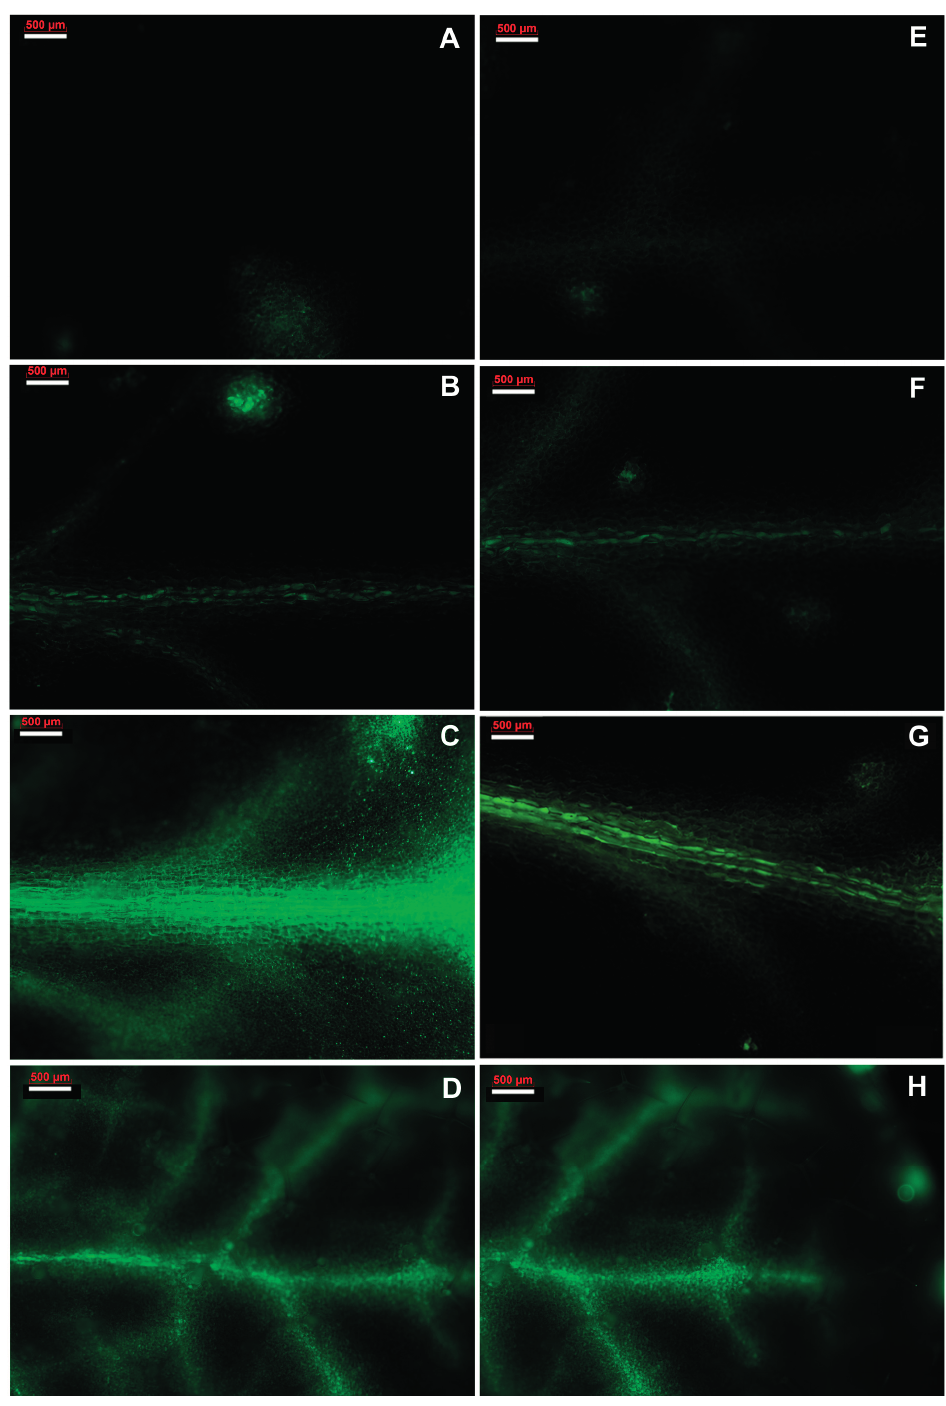
Figure 6. Representative patterns of H 2 O 2 production in young ( A – D ) and mature ( E – H ) leaves of A. thaliana as indicated by the fluorescence of 2 ′ ,7 ′ -dichlorodihydrofluorescein diacetate (DCF-DA), in the absence or in the presence of Pq. H 2 O 2 content in a control young leaf ( A ) and a mature leaf ( E ); H 2 O 2 content 30 min after Pq treatment in a young leaf ( B ) and in a mature leaf ( F ); H 2 O 2 content 60 min after Pq treatment in a young leaf ( C ) and in a mature leaf ( G ); H 2 O 2 content 4 h after Pq treatment in a young leaf ( D ) and in a mature leaf ( H ). Scale bars: 500